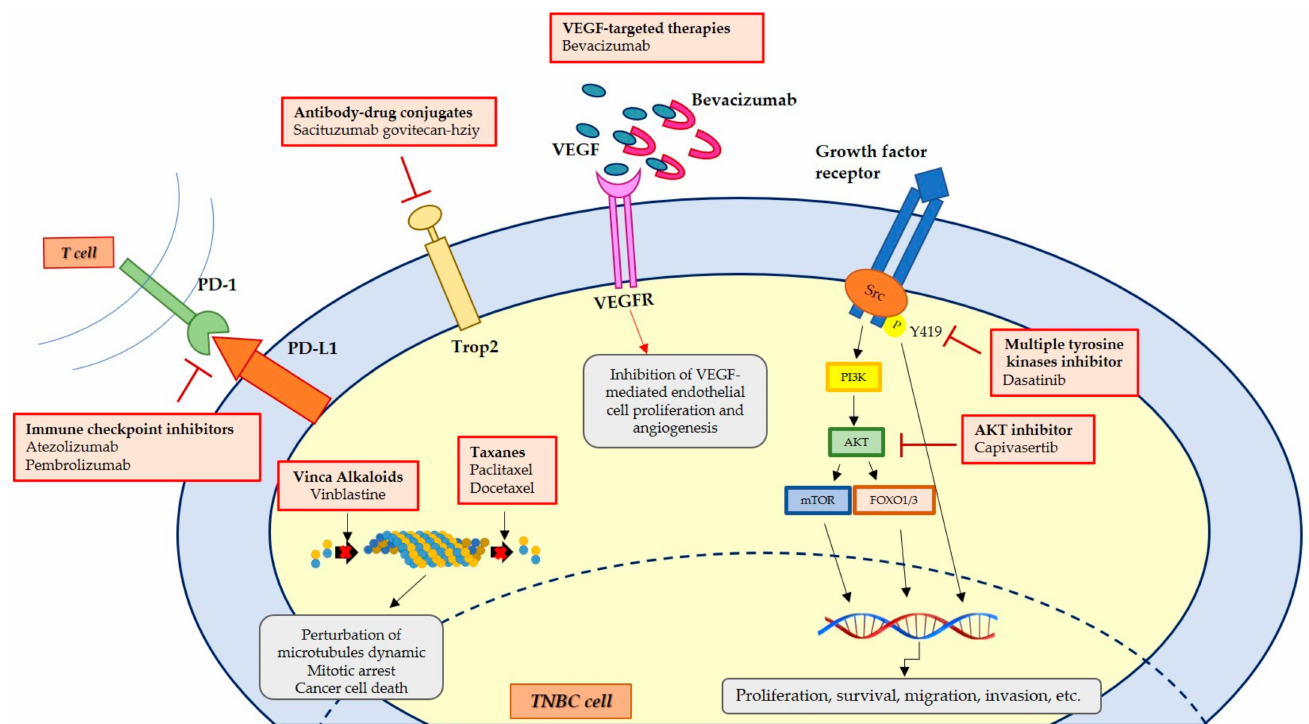
Figure 1. Traditional therapeutic treatments for